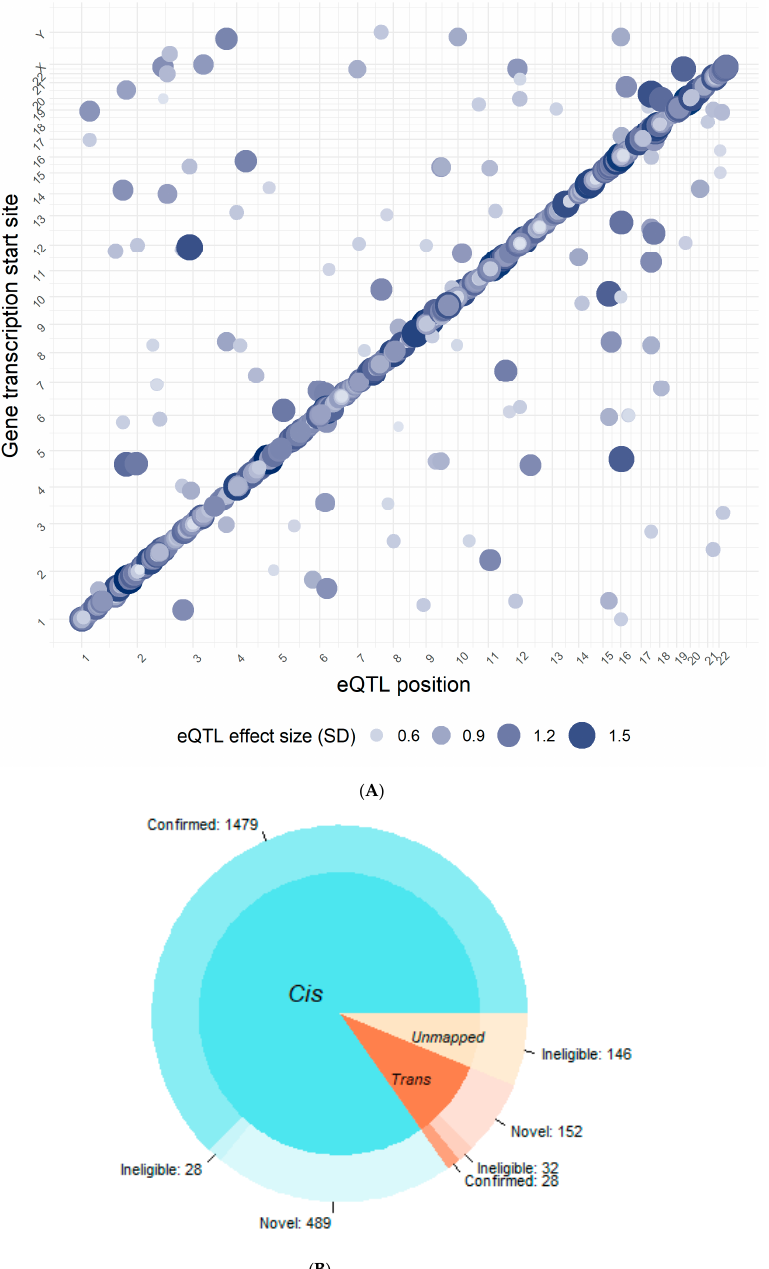
Figure 1. ( A ) Results of the pulmonary arterial hypertension (PAH) Cohort eQTL mapping. Genomic eQTL location ( x -axis) plotted against the transcription start site of the gene associated with the eQTL. Bubble size and color are proportional to the effect size of the eQTL-gene association. ( B ) Pie chart showing the proportions of cis -, trans - and unmapped eQTL identified in the PAH Cohort eQTL